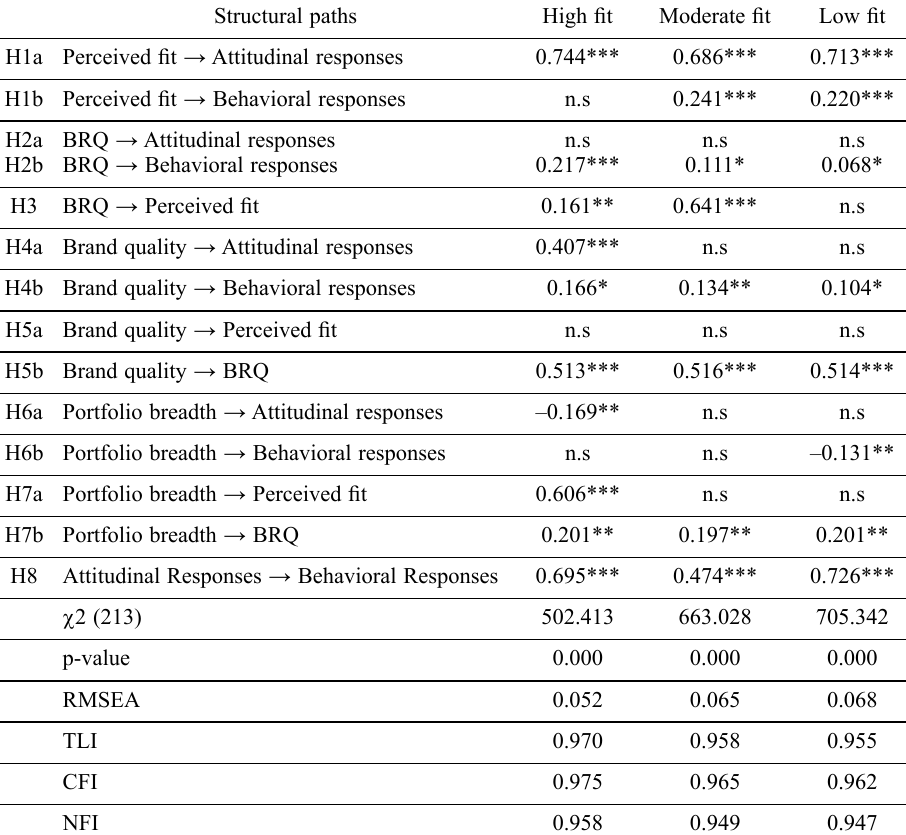
Table 3. Summary of the findings Structural